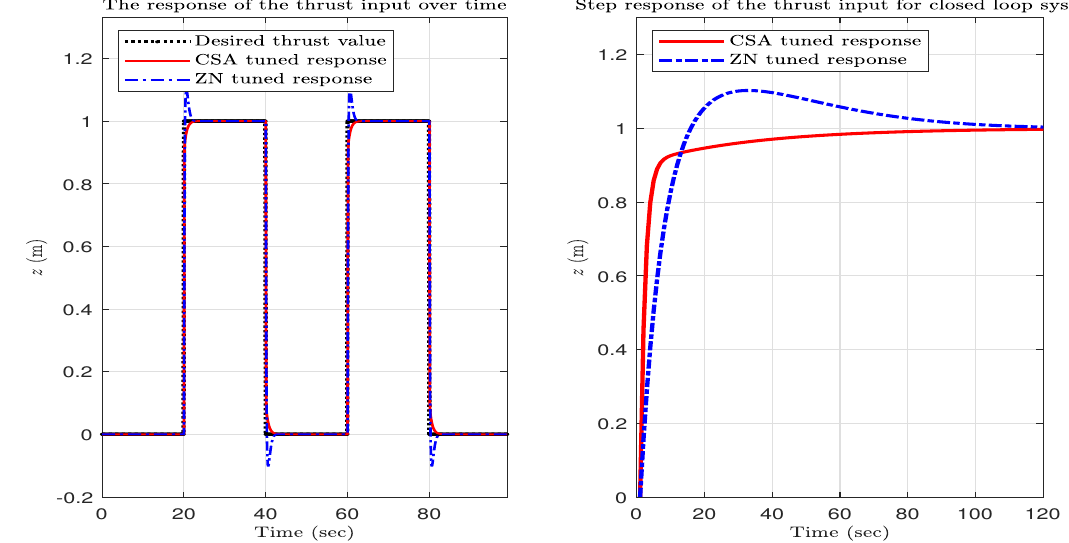
Figure 18. Simulated output responses of the thrust input of a quadcopter using CSA and ZN methods.